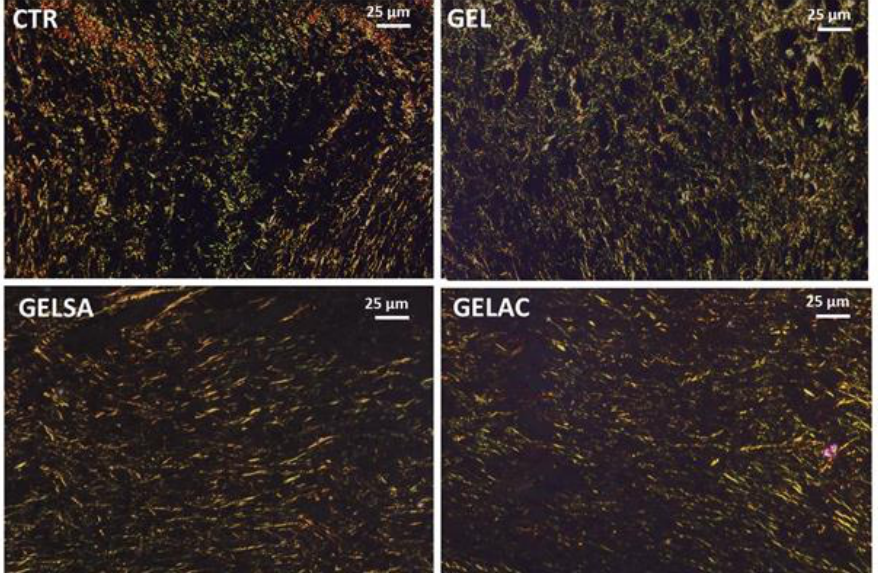
Figure 16. Photomicrographs of histological sections stained in picrosirius and analyzed under polarized light representative of the 7-day repair process. All groups present thin and short collagen fibrils with yellow-green birefringence compatible with type III collagen, interspersed with thicker fibers with golden birefringence, consistent with type I collagen, arranged in a predominantly reticular pattern in CTR and GEL, but with areas parallel (especially in wound depth) in GELSA and GELAC; the interfibrillar spaces (dark) were notably smaller but still abundant (400×). Caption: CTR — control group; GEL — group treated only with gelatin biomembranes; GELSA — group treated with gelatin biomembranes containing S. adstringens extract; GELAC — group treated with A. cochliacarpa extract.